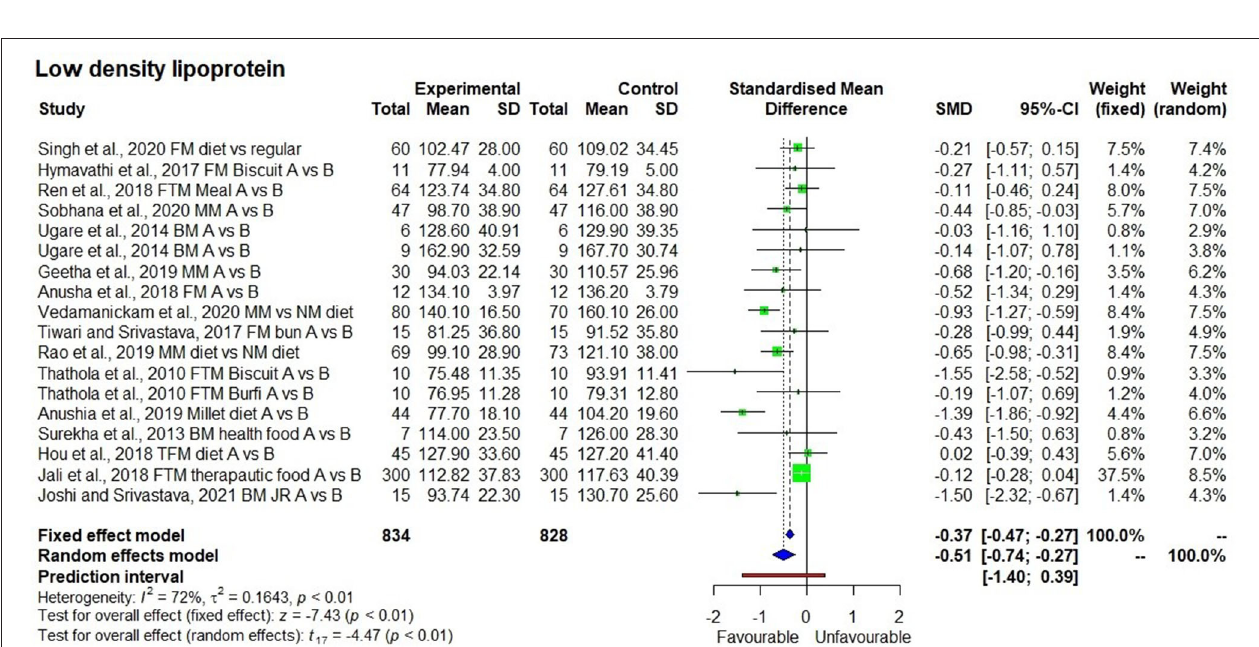
FIGURE 4 | Effect of consuming millets on low-density lipoprotein-cholesterol (LDL-C) level (pre- vs. post-treatment or intervention vs. control diet).